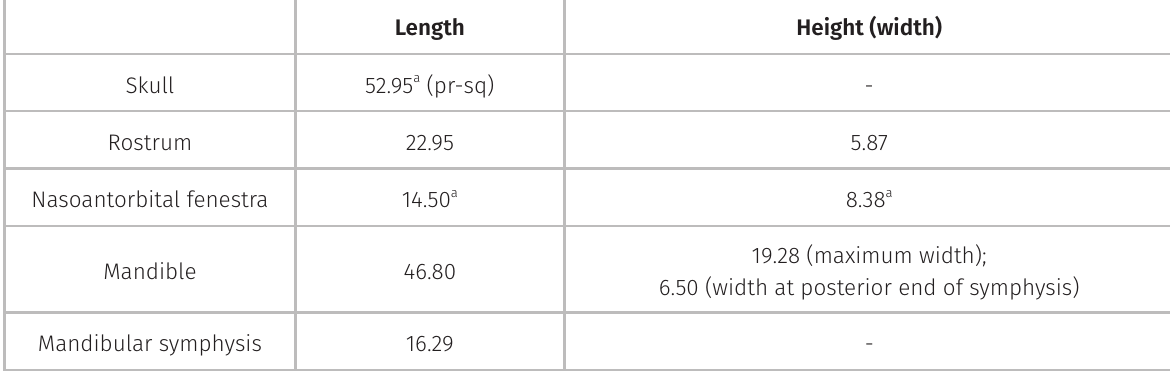
Table I. Measurements of cranial elements in Kunpengopterus sinensis (STM 19-59) (in